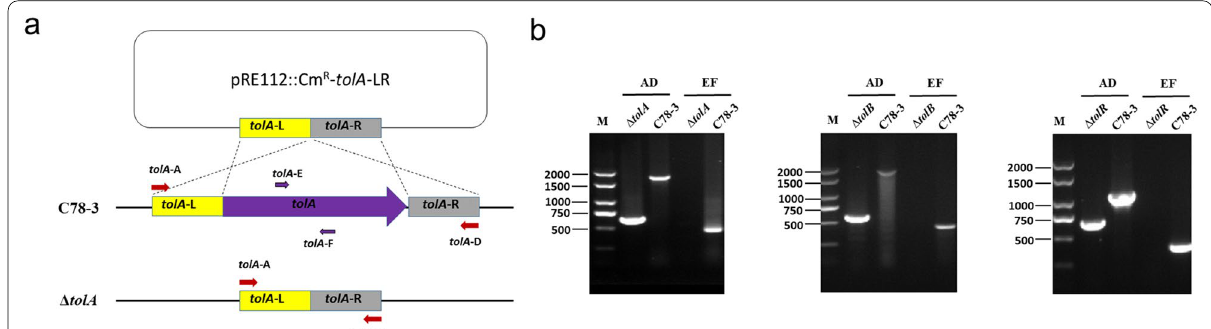
Fig. 1 Construction and confirmation of the tolA , tolB , and tolR knockout mutants. a Schematic diagram for the generation of the tolA , tolB , and tolR mutants. b The tolA , tolB , and tolR mutants were verified through combined PCR. PCR confirmation of the deletions using two primer sets of flanking regions (A/D) and internal regions